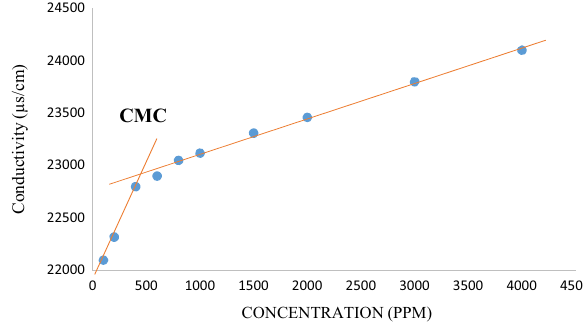
Fig. 4 CMC of SDS by conductivity calibration curve